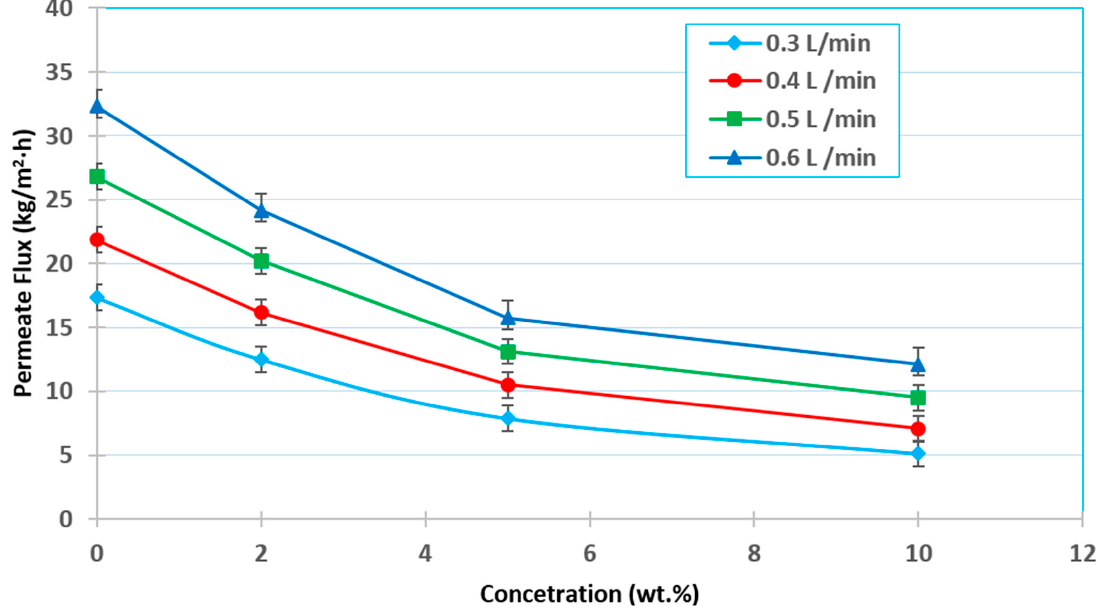
Figure 9. Effect of the initial feed concentration on the permeation flux at a 30 °C feed temperature and 60 mmHg (abs) absolute pressure.